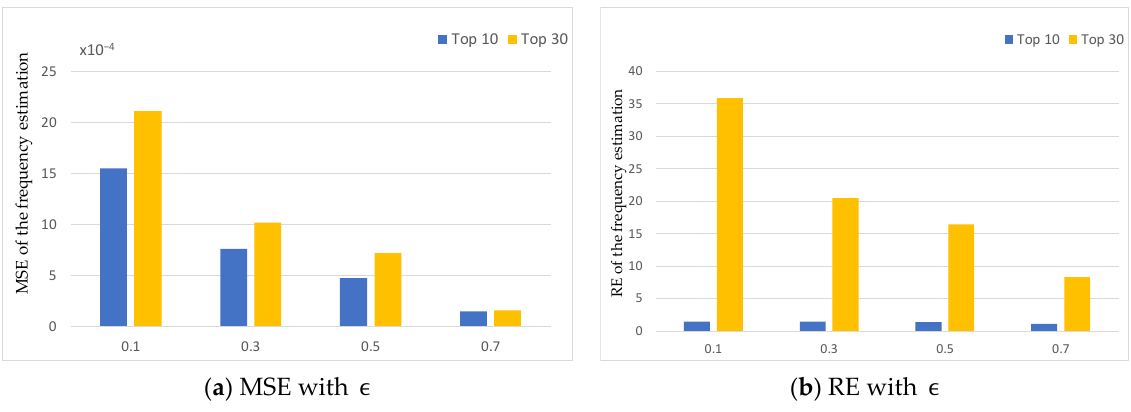
Figure 6. MSE and RE of the frequency estimation with different δ .